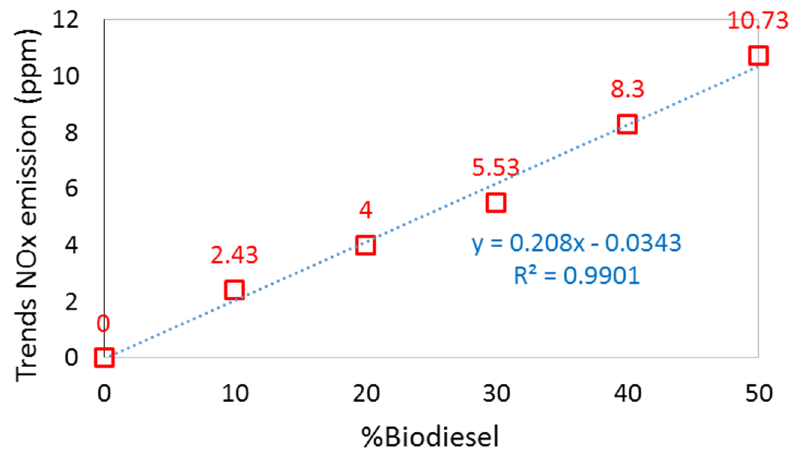
Figure 11. Trending NOx emission follows biodiesel blends.